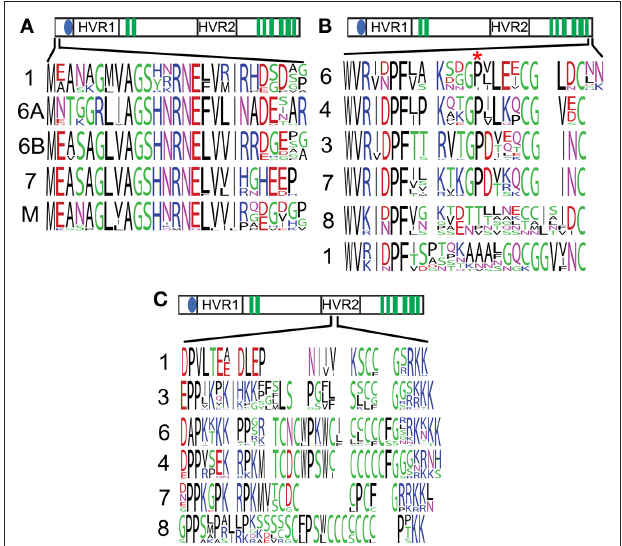
( Figure 2B ), following the cysteine-rich region ( Figure 3C ). The secondary CesAs 4, 7, and 8 have lost the region corresponding to